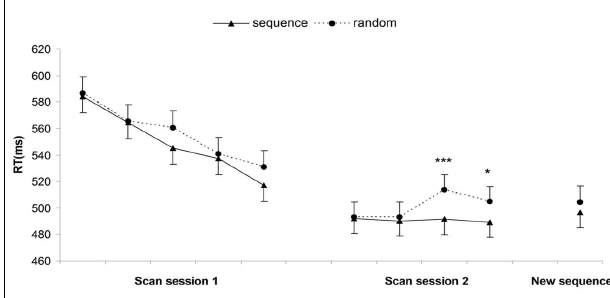
FIGURE 3 | Behavioral performance during scanning session 1 and 2: mean of the median reaction times in each block, for sequence and random trials separately. Error bars represent the within-subject 95% confidence intervals (Loftus and Masson, 1994), * p < 0.05, *** p <